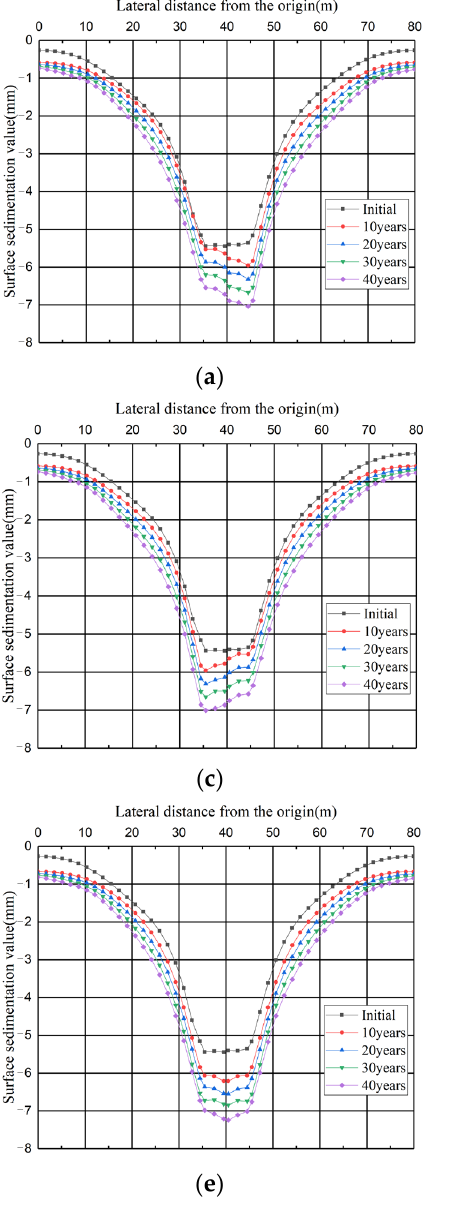
Figure 13. Development of the longitudinal surface settlement curve caused by dissolution deterioration at the same location. ( a ) Longitudinal settling tank for working condition A. ( b ) Longitudinal settling tank for working condition B. ( c ) Longitudinal settling tank for working condition C. ( d ) Longitudinal settling tank for working condition D. ( e ) Longitudinal settling tank for working condition E. ( f ) Longitudinal settling tank for total dissolution working condition F.